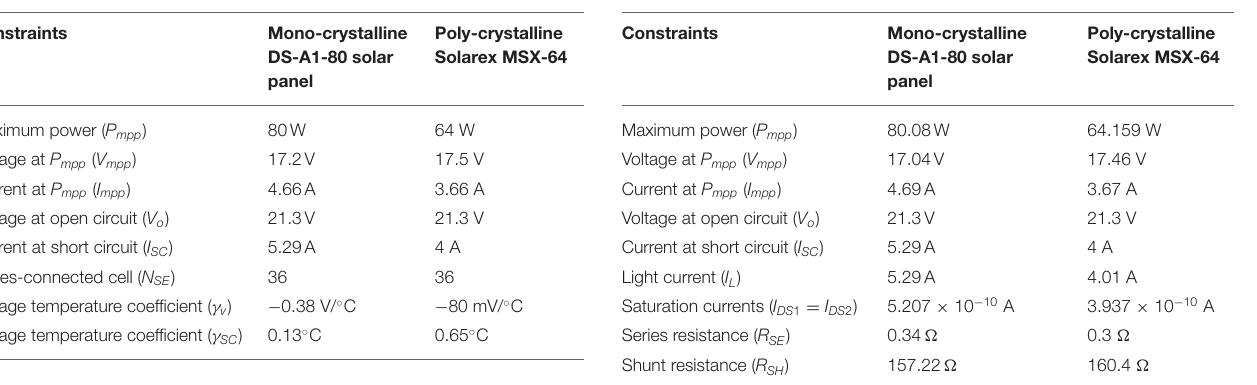
TABLE 1 | Component specifications from constructor data sheet. TABLE 2 | Estimated values of proposed two-diode model.